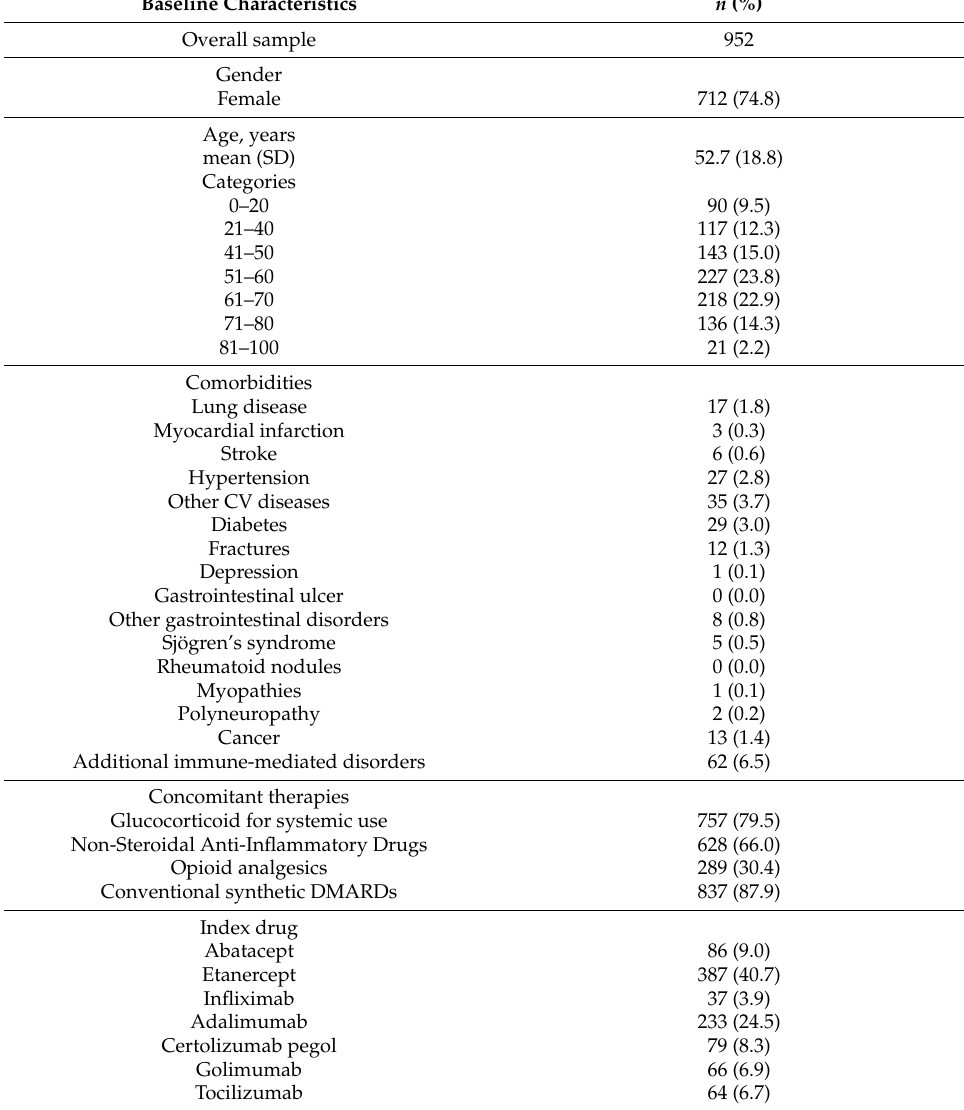
Table 1. Distribution of baseline characteristics of 952 new users of biologic DMARDs in 2010–2015 in